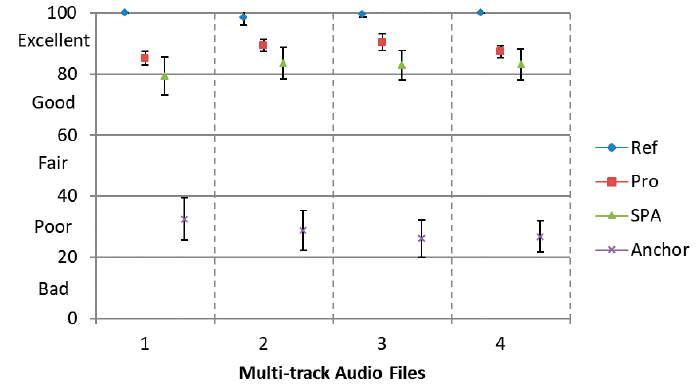
Figure 6. MUltiple Stimuli with Hidden Reference and Anchor (MUSHRA) test results for the SPA framework and the proposed framework with 95% confidence intervals.